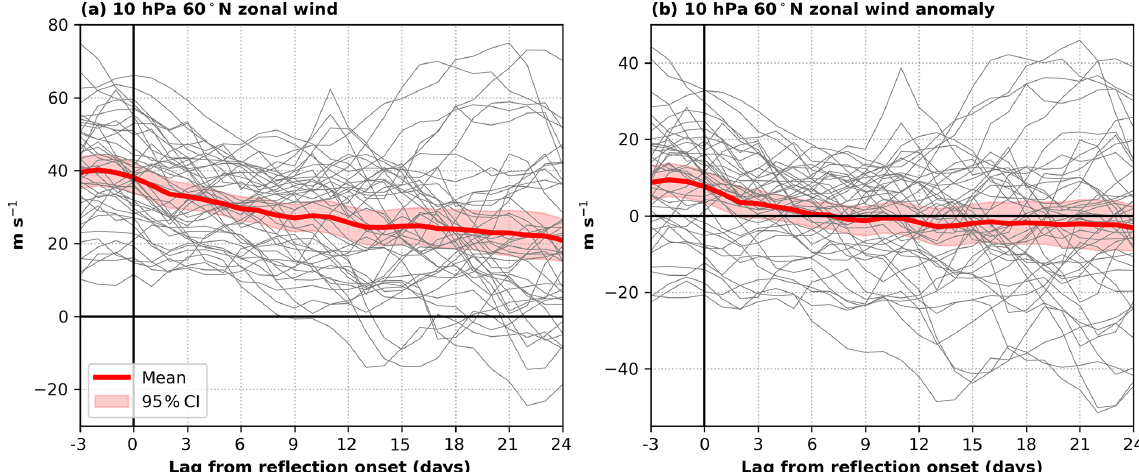
Figure A5. Evolution of the 10hPa 60 ◦ N zonal-mean zonal wind (a) and anomalies (b) for the 44 reflection events. The thick red line denotes the average over all events. Red shading indicates the 95% confidence interval on the mean assessed as described in Sect. 2.